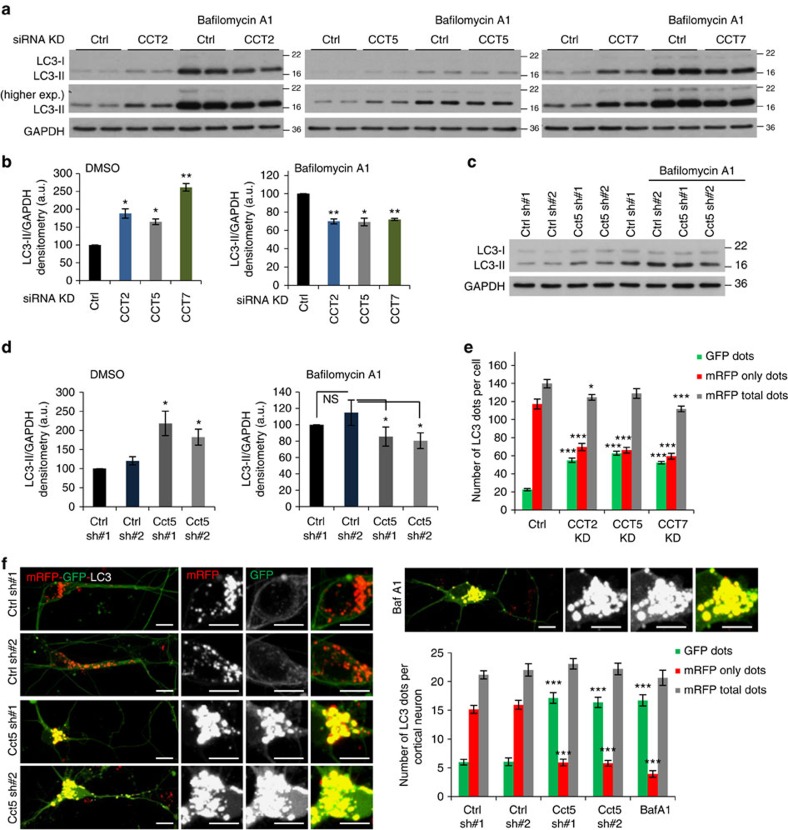
CCT knockdown reduces LC3 turnover and autophagosome formation.(a) LC3-II levels in HeLa cells transfected with siRNA against scrambled control or CCT subunits treated with vehicle (DMSO) or Bafilomycin A1 (400 nM) for 5 h. GAPDH is loading control. (b) LC3-II/GAPDH densitometry from a. Graphs show means±s.d. of triplicate samples in the absence or presence of Bafilomycin A1. Similar results were observed in at least three independent experiments. (n=3; **P<0.01, *P<0.05; two-tailed one sample t-test). For combined data of independent biological replicates, see Supplementary Fig. 1c. (c) LC3-II levels in mouse primary cortical neurons transduced with two different shRNA lentiviral particles targeting either control (Ctrl sh#1 is empty vector and Ctrl sh#2 is control scramble) or the mouse Cct5 (Cct5 sh#1 and Cct5 sh#2). Cells were treated with vehicle (DMSO) or Bafilomycin A1 at 200 nM for 12 h. GAPDH is loading control. (d) LC3-II/GAPDH densitometry from c. Graphs show mean±s.d. of triplicate samples in the absence or presence of Bafilomycin A1. Similar results were observed in another two independent experiments. In Bafilomycin A1 conditions, the Cct5 shRNAs (#1 or #2) treated cells showed significant reduced LC3-II levels when compared with the scramble control (Ctrl sh#2) treated neurons (n=3; *P<0.05, NS, not significant; two-tailed t-test), but not-significant if compared with the empty-vector control (Ctrl sh#1) condition (n=3; NS, not significant; two-tailed one sample t-test). (e) GFP dot numbers (autophagosomes/non-acidified autolysosomes, mRFP-GFP double labelled vesicles) and mRFP-only dots (acidified autolysosomes) in HeLa cells. HeLa cells stably expressing mRFP-GFP-LC3 were treated as in a then seeded in a 96-well plate and subjected to automated Cellomics visualization and analysis. Graph shows results from one representative experiment. We analysed 100–200 cells per well (from a 96-well plate) with 10–12 wells per condition. Similar data were seen in other two independent experiments. Bars—means±s.e.m. (***P<0.001; two-tailed t-test). (f) Representative confocal z-stack images (left panel) and total number of GFP dots (autophagosomes) and mRFP-only dots (autolysosomes)—left panel, in mouse primary cortical neurons from mRFP-GFP-LC3 transgenic mice. Cortical neurons were plated in live cell dishes, treated as in d and the numbers of dots were manually counted after confocal microscopy. Graph shows data from three independent biological replicates; 100–150 neurons counted per each condition. Bars—means±s.e.m. (***P<0.001; two-tailed t-test). Scale bar—10 μm.